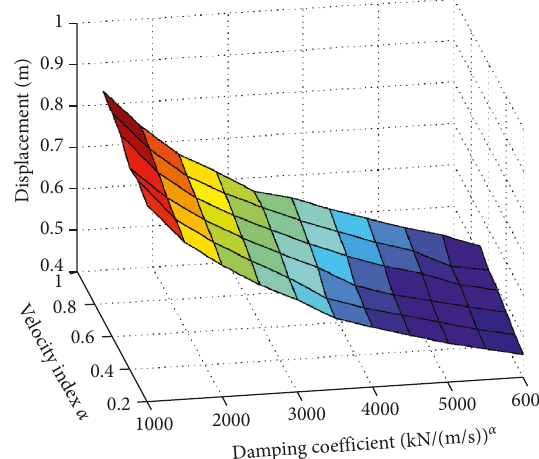
Figure 13: Longitudinal displacement of the top section of the main tower.